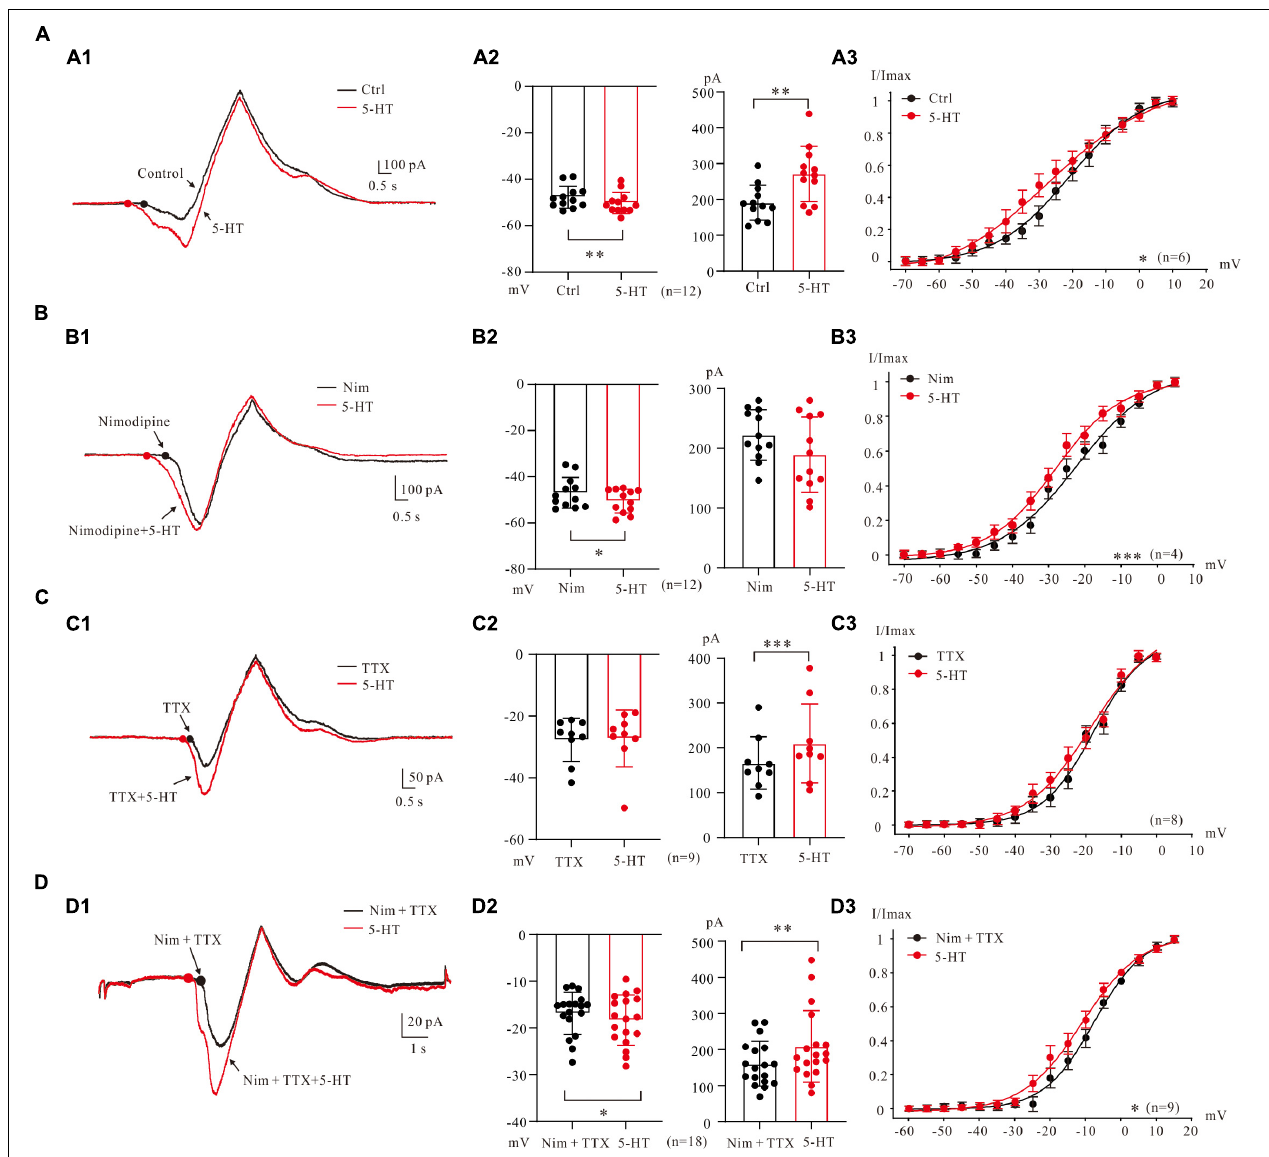
FIGURE 5 | 5-HT modulation of PICs. (A) The 5-HT modulation of PICs. (A1) Overlapped current traces recorded by voltage ramps in control (black) and 20 µ M 5-HT (red). (A2) Summary diagrams show the onset and amplitude of PICs recorded in control and presence of 15–20 µ M 5-HT ( n = 12). (A3) 5-HT significantly hyperpolarized the V mid , n = 6, P < 0.05. (B) The 5-HT modulation of Na_PIC + TDR_PIC. (B1) Overlapped current traces recorded by voltage ramps in application of Nimodipine (25 µ M, black) and 20 µ M 5-HT (red). (B2) Summary diagrams show the onset and amplitude of Na_PIC + TDR_PIC recorded in control and presence of 15–20 µ M 5-HT ( n = 12). (B3) 5-HT significantly hyperpolarized the V mid , P < 0.001, n = 4. (C) The 5-HT modulation of Ca_PIC + TDR_PIC. (C1) Overlapped current traces recorded by voltage ramps in control (black) and 20 µ M 5-HT (red). (C2) Summary diagrams show the onset and amplitude